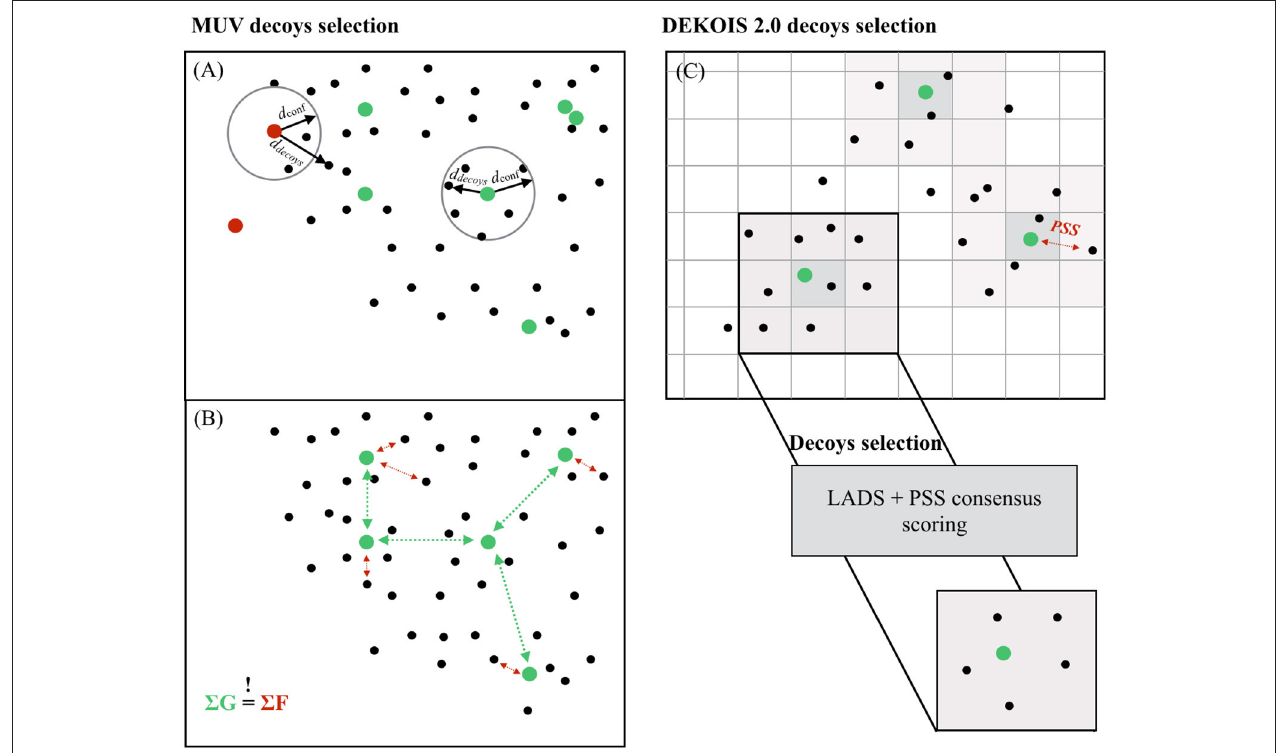
FIGURE 1 | Decoys selection in MUV and DEKOIS 2.0. (A) For each active of the MUV, a distance to the 500th nearest neighbor from 100 random samples from multiple drug-like compounds collections was computed. The 90th percentile was recorded as the confidence distance for a good embedding (d conf ). Active compounds were accepted only if the 500th nearest neighbor from the decoy compounds (d decoys ) set was within the d conf . (B) Selected active compounds datasets from the MUV were adjusted to the same level of spread ( 6 G ≈ constant), and decoy compounds sets were, in turn, adjusted to this level of spread ( 6 F ≈ 6 G). (C) The chemical space of both active and decoy compounds was divided into cells characterized by a set of 8 physicochemical properties. Each user-provided compound is associated with its property matching cell, and 1,500 decoys are selected from the same cell, or direct neighboring cells if the parent cell is not populated